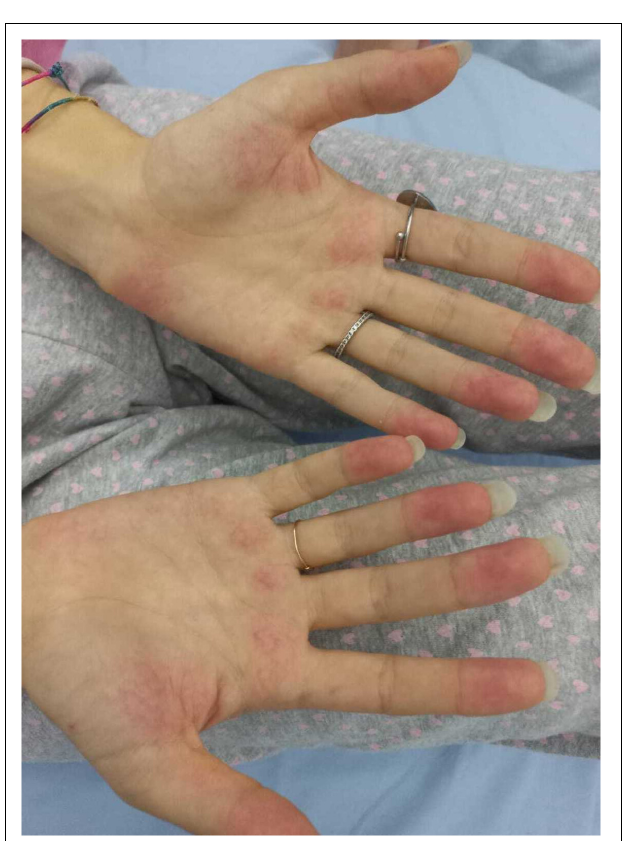
FIGURE 2 | Acral hand vasculitis in our